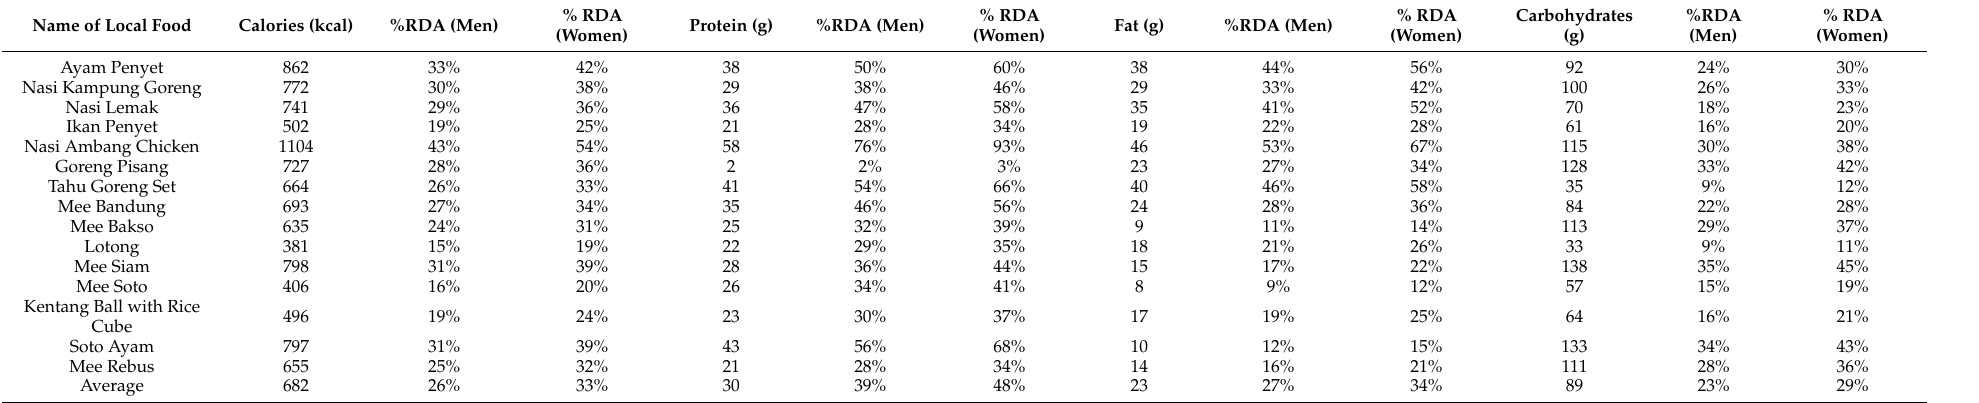
Table 5. Energy and macronutrient content and the %RDA of the commonly consumed Malay